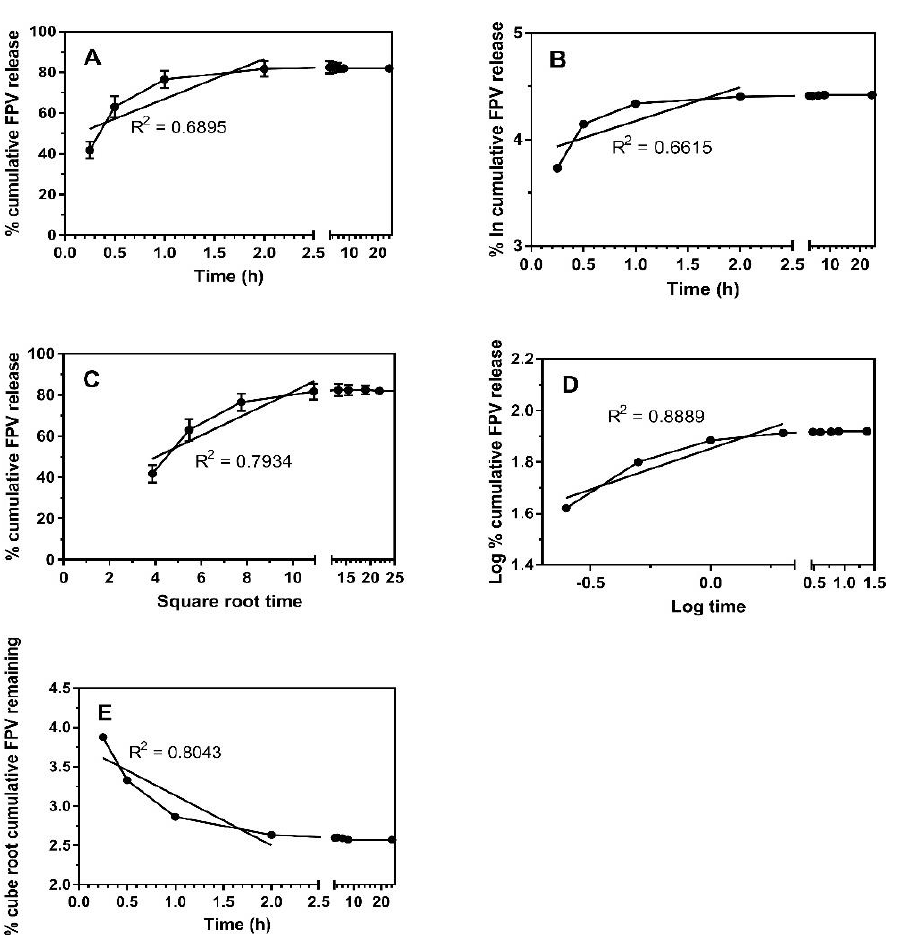
Figure 3. Drug release kinetics of FPV-SLNs fitted to mathematical kinetic model. ( A ) Zero order, ( B ) first order, ( C ) Higuchi model ( D ) Korsmeyer–Peppas model and ( E ) Hixson–Crowell model. It should be noted that only cumulative release of FPV until 2 h is fitted to the model. Solid black circle refers to FPV release.